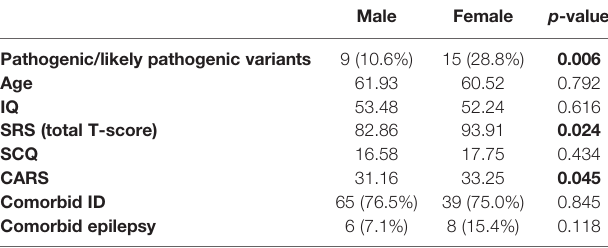
TABLE 2 | Male – Female comparison.